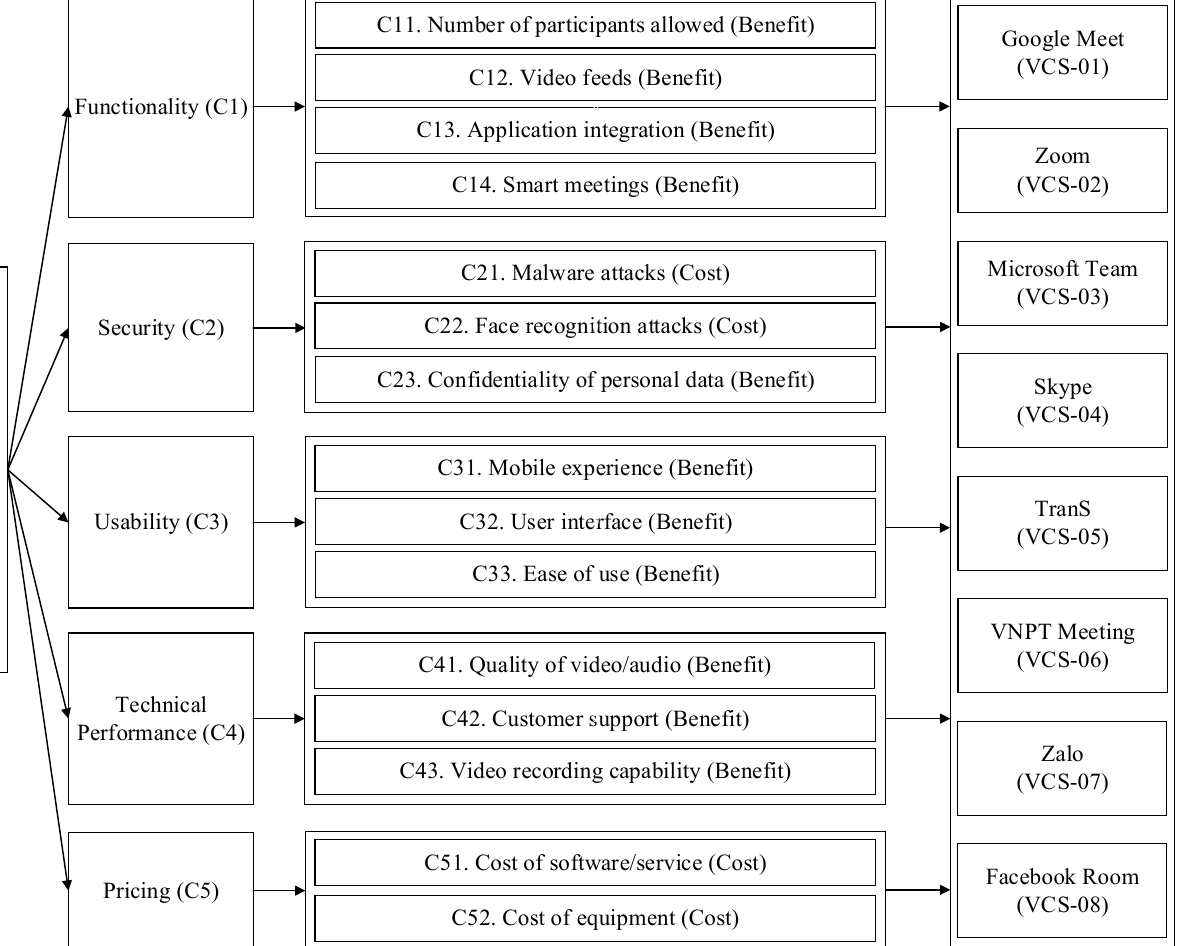
Table 6. The crisp matrix of